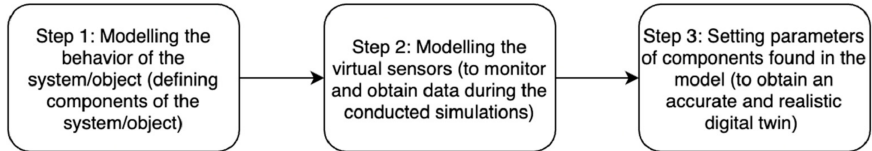
Figure 1. Modeling step—first step of the methodology. The system modeled consists of a motor and gearbox. The circuit includes components from electrical, thermal, rotational motion, and translational motion domains. The system represents the motor circuit of the main driver of a metal sheet roller machine. Two main base components of the model are the universal (electrical and mechanical components) motor, driven by a DC voltage source, and the gearbox, which reduces the rotation of the motor. The DC-driven universal motor of the circuit is designed based on electrical (Kirchhoff’s voltage law) and mechanical (Newton’s second law of motion) equations. The + v two governing equations of the motor are v = Ri + L di e (Kirchhoff’s voltage law), dt where v is the input voltage, R is the motor resistance, i is the motor current, L is the motor inductance, and v e is the back electromotive force, and T e = T L + B ω + J L d ω (Newton’s dt law), where T e is the electromotive torque, T L is the load torque, J L is the total inertia, ω is the angular velocity, and B is the angular friction. The two equations are connected by the relationship between electromotive force and angular velocity ( v e = K v ω , where K v is the back electromotive force constant), as well the relationship between the torque and current ( T e = K t i , where K t is the torque constant). Figure 2 below shows a simple physics-based schematic of a DC-driven universal motor